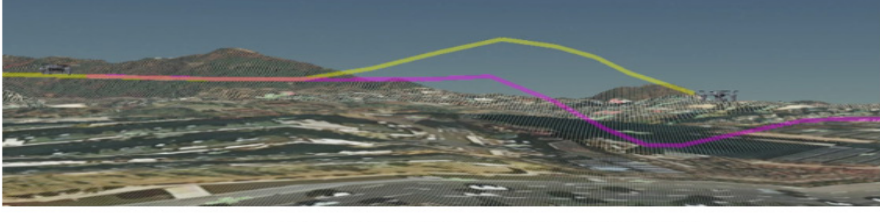
Figure 17. Simulation of Scenario #2 (deconfliction study by altitude).